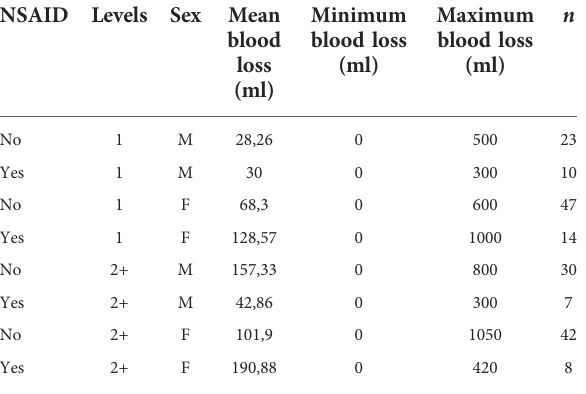
TABLE 5 Resulting p -values when testing for equal drainage distributions in patients with and without NSAID in the four different subgroups formed by sex and (aggregated) number of